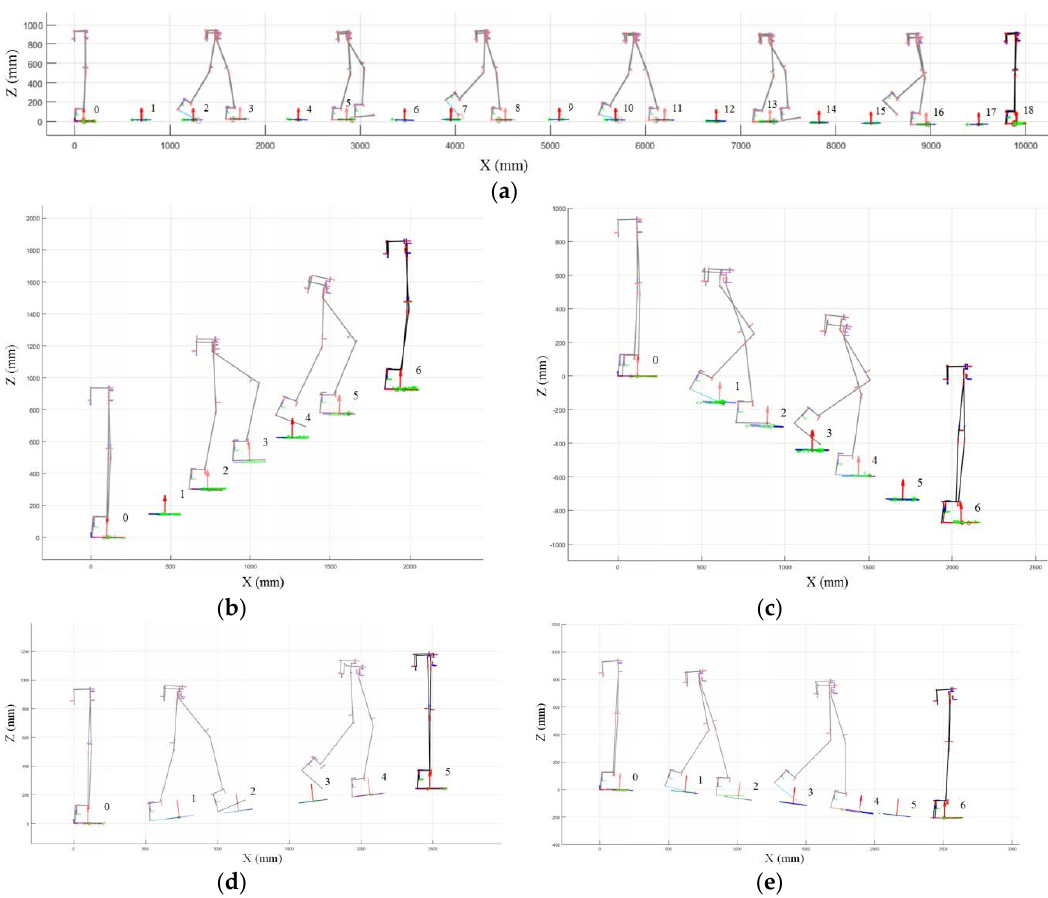
Figure 22. Visualization of position data of the exoskeleton on frame {W} for ( a ) level walk, ( b ) stair ascent, ( c ) stair descent, ( d ) ramp ascent, and ( e ) ramp descent.